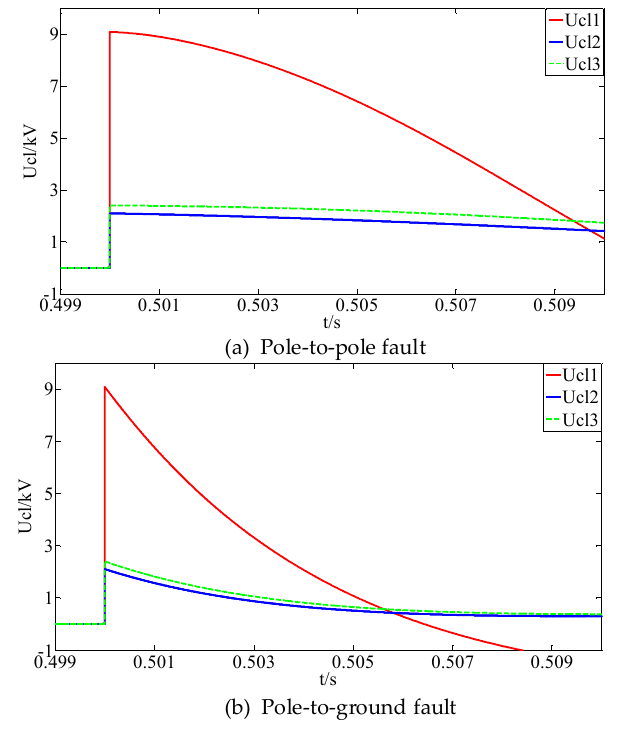
Figure 6. Simulation results of the voltages of the CLIs during DC faults.